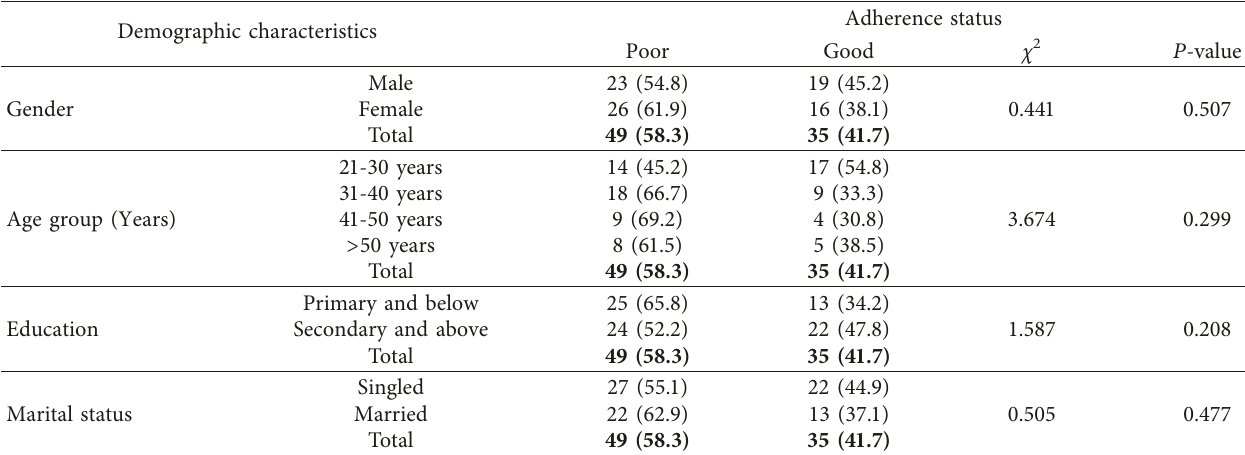
Table 4: Adherence to TB treatment and demographic characteristics among the participants from Buea and Kumba Hospitals.